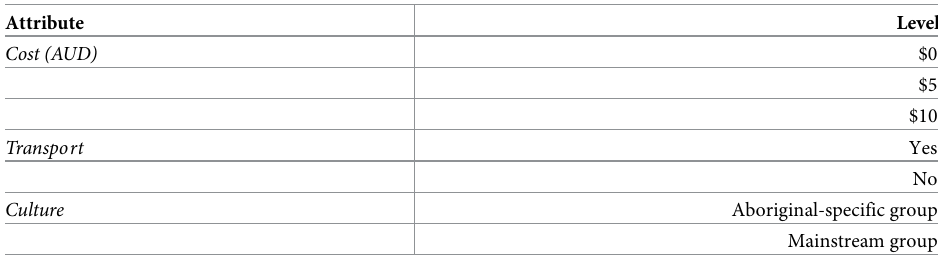
Table 1. Attributes and levels used in final